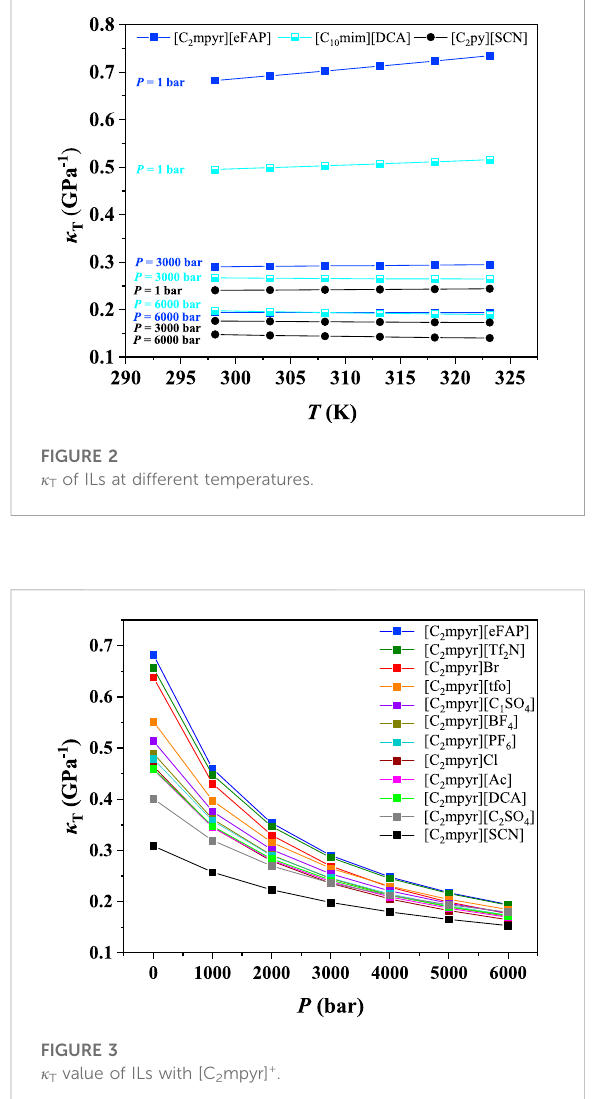
Figure 2, evidencing that the compressibility is slightly affected by temperature. Other ILs also showed the same phenomena.